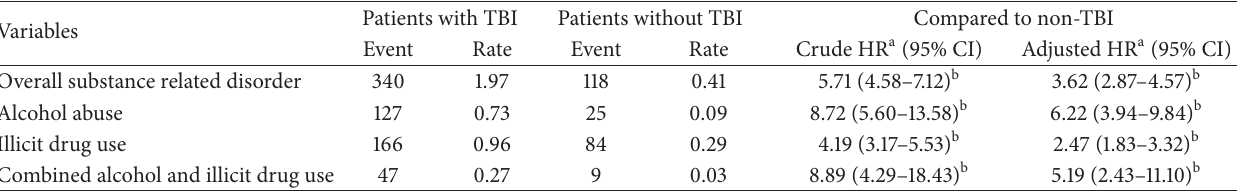
Combined alcohol and illicit drug